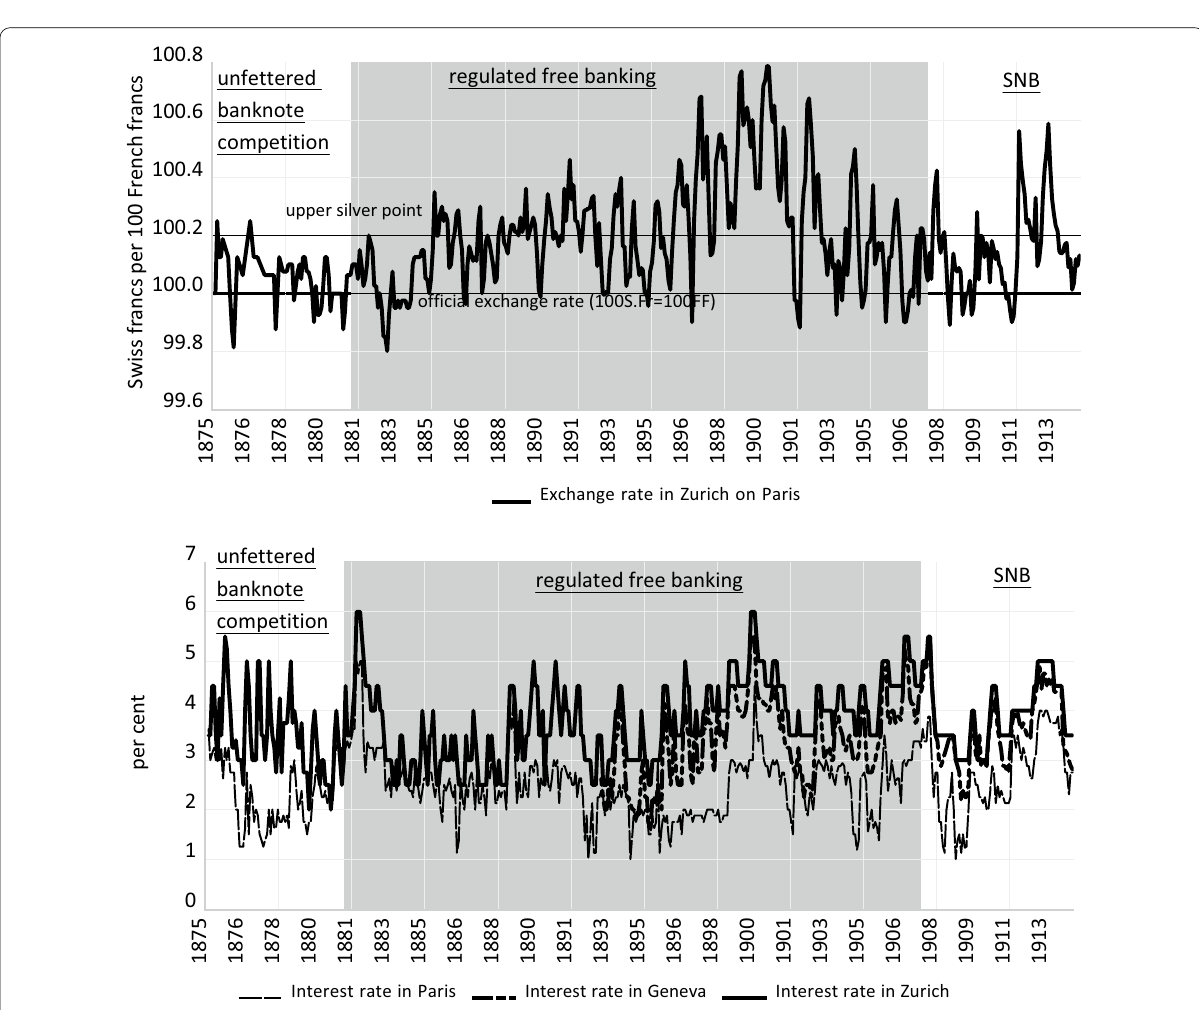
Fig. 2 Exchange rate and interest rates in Switzerland (1875–1914). Notes: The data refer to the last Saturday of the month and cover the 1875 (January) to 1914 (June) period. In the top panel, the exchange rate between Swiss and French francs refers to the market rate on bills of exchange in Zurich on Paris (average between bid and ask rate). The data have been compiled from Kalkmann (1900, pp.98–137) for the years between 1880 and 1900, and the newspaper “Neue Zürcher Zeitung” (NZZ) for other years. In the bottom panel, the (private) interest rates for Paris and Geneva (covering the years from 1893 onwards) refer to the quotations of discount rates in the open money market as reported by Neal and Weidenmier (2003). For Zurich, the interest rate refers to the discount rate of the bank “Credit Suisse” and has been collected from Kalkmann (1900, pp.140–179) for the years between 1880 and 1900, and the “Neue Zürcher Zeitung” (NZZ) for other years. The data can be downloaded at https:// nherg er. com/ histo rical-